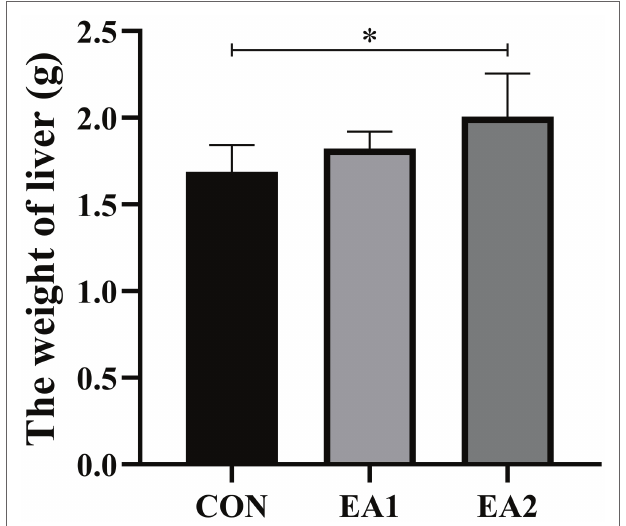
FIGURE 1 | Effects of EA supplementation on liver weight in C57BL/6J mice. The values are reported as the mean ± SD of 12 mice per group: * p < 0.05 represents significant differences compared with the control